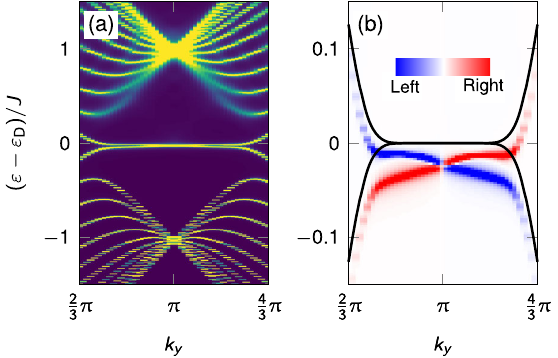
ε Þ FIG. 8. Interaction-corrected magnonic spectral function A k y ð of a honeycomb-lattice slab of finite width (in the x direction), ε Þ of a slab with a width of revealing chiral edge states. (a) A k y ð 12 unit cells. Blue (yellow) color indicates zero (maximal) values; D=J ¼ 0 . 15 , S ¼ 1 and B= ð JS Þ ¼ 1 . (b) Position-resolved FIG. 7. Mass term d 3 in the first Brillouin zone at B= ð JS Þ ¼ 4 . k ε Þ , with blue (red) color indicating localization at the left A Blue, white, or red color indicates negative, zero, or positive k y ð values. Note the opposite sign of d 3 at the K and K 0 points, (right) edge. Black lines indicate the flat harmonic edge state k causing nonzero Chern and winding numbers. The parameters connecting the edge projections of the Dirac cones for zigzag used are S ¼ 1 and D=J ¼ 0 . 15 .